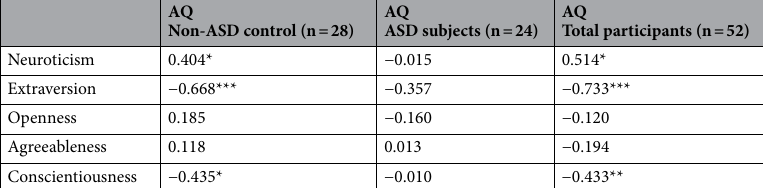
Table 5. Correlations between AQ scores and NEO categories. Values are Pearson’s r correlations. * p < 0.05,** p < 0.01,*** p < 0.001 in each group. AQ autism-spectrum quotient, NEO NEO Personality Inventory-